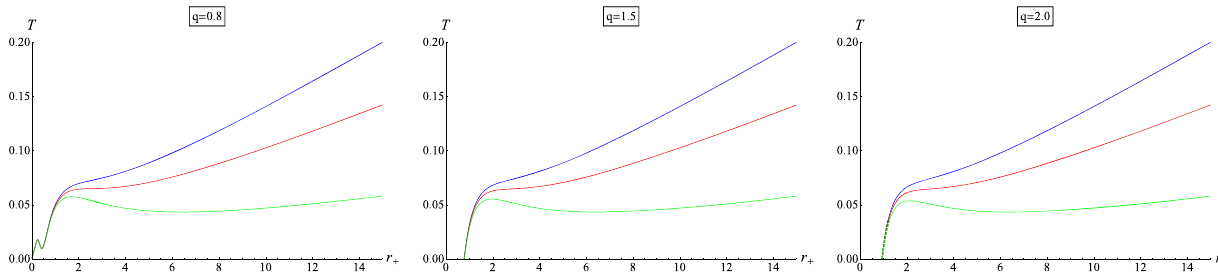
, 1 , 3 , respectively. There is no black hole solution in the dashed part 100 π 48 π 400 π